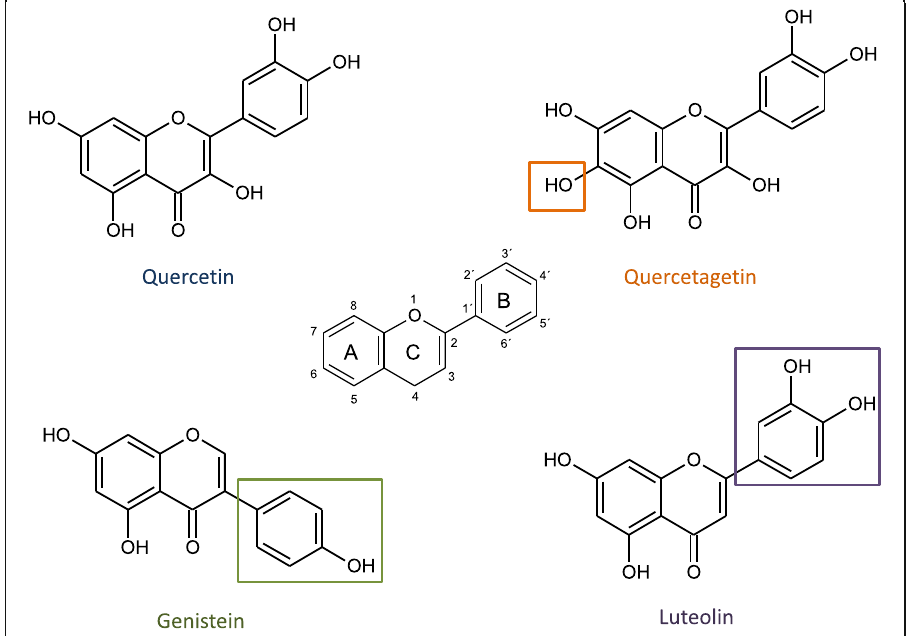
Fig. 1 The chemical structures of quercetin, quercetagetin, genistein and luteolin. The central structure is that of a flavone. It has two phenyl rings (A and B) joined by a pyran ring (C). The boxes frame the substituents of their structure with respect to the flavonoid